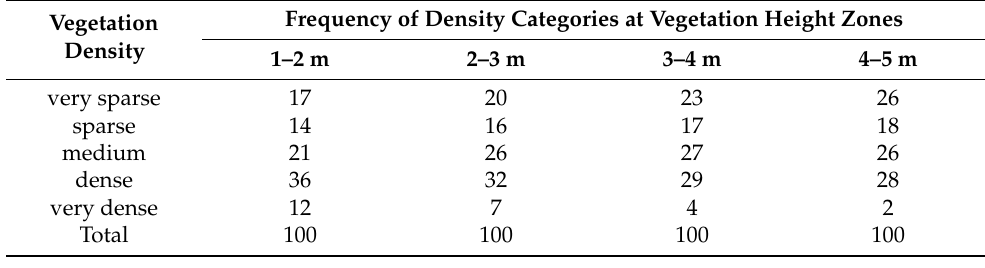
Table 5. Frequency (%) of vegetation density categories in the different flooded height zones. Frequency of Density Categories at Vegetation Height Zones Vegetation Density 1–2 m 2–3 m 3–4 m 4–5 m very sparse 17 20 23 26 sparse 14 16 17 18 medium 21 26 27 26 dense 36 32 29 28 very dense 12 7 4 2 Total 100 100 100